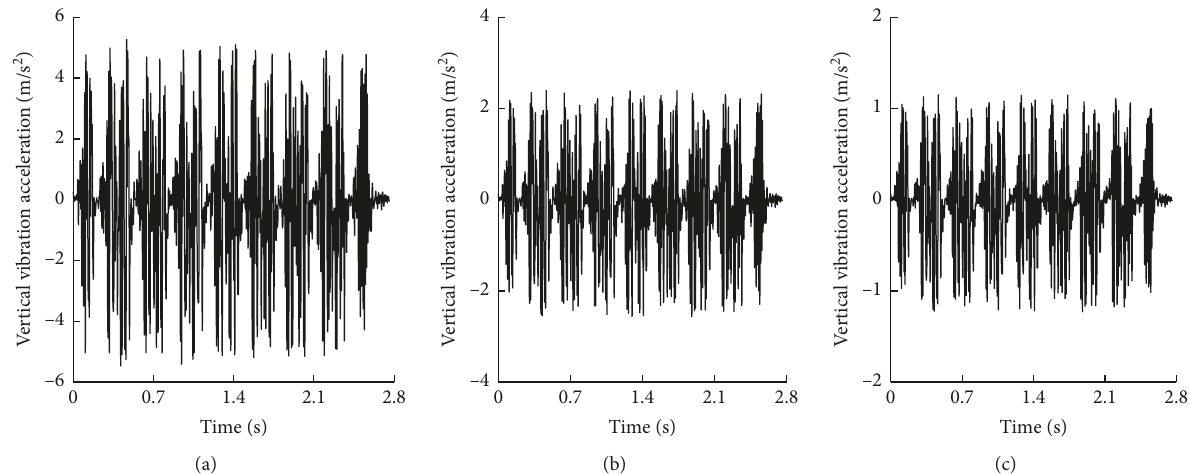
Figure 10: The vertical vibration acceleration history curves of the ballastless track-subgrade after mud pumping reinforcement ( v 283km/h). (a) The track slab. (b) The concrete base. (c) The subgrade (cid:31)